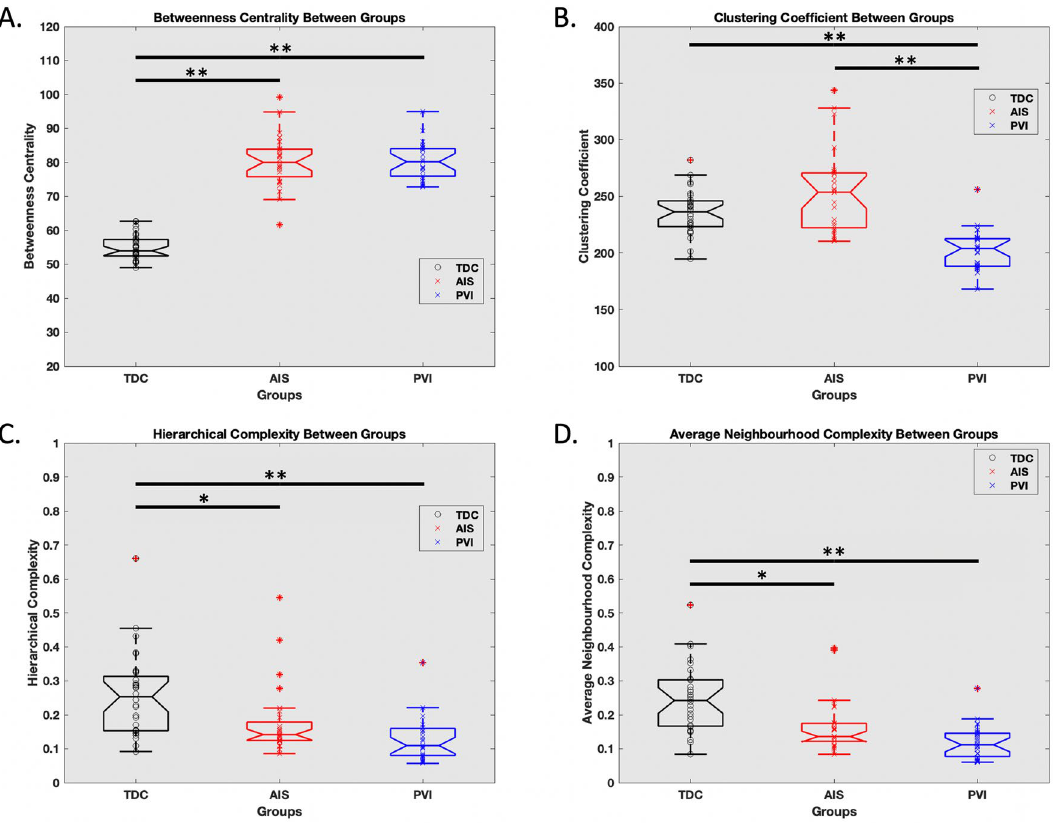
Figure 4. Hemispheric network metrics between group comparisons. ( A ) Betweenness centrality was higher in AIS and PVI compared to TDC. ( B ) Clustering coefficient was higher in TDC and AIS compared to PVI. Hierarchical complexity, ( C ) average neighbourhood complexity, ( D ) were higher in TDC compared to AIS and PVI. **p < 0.001, *p < 0.01.